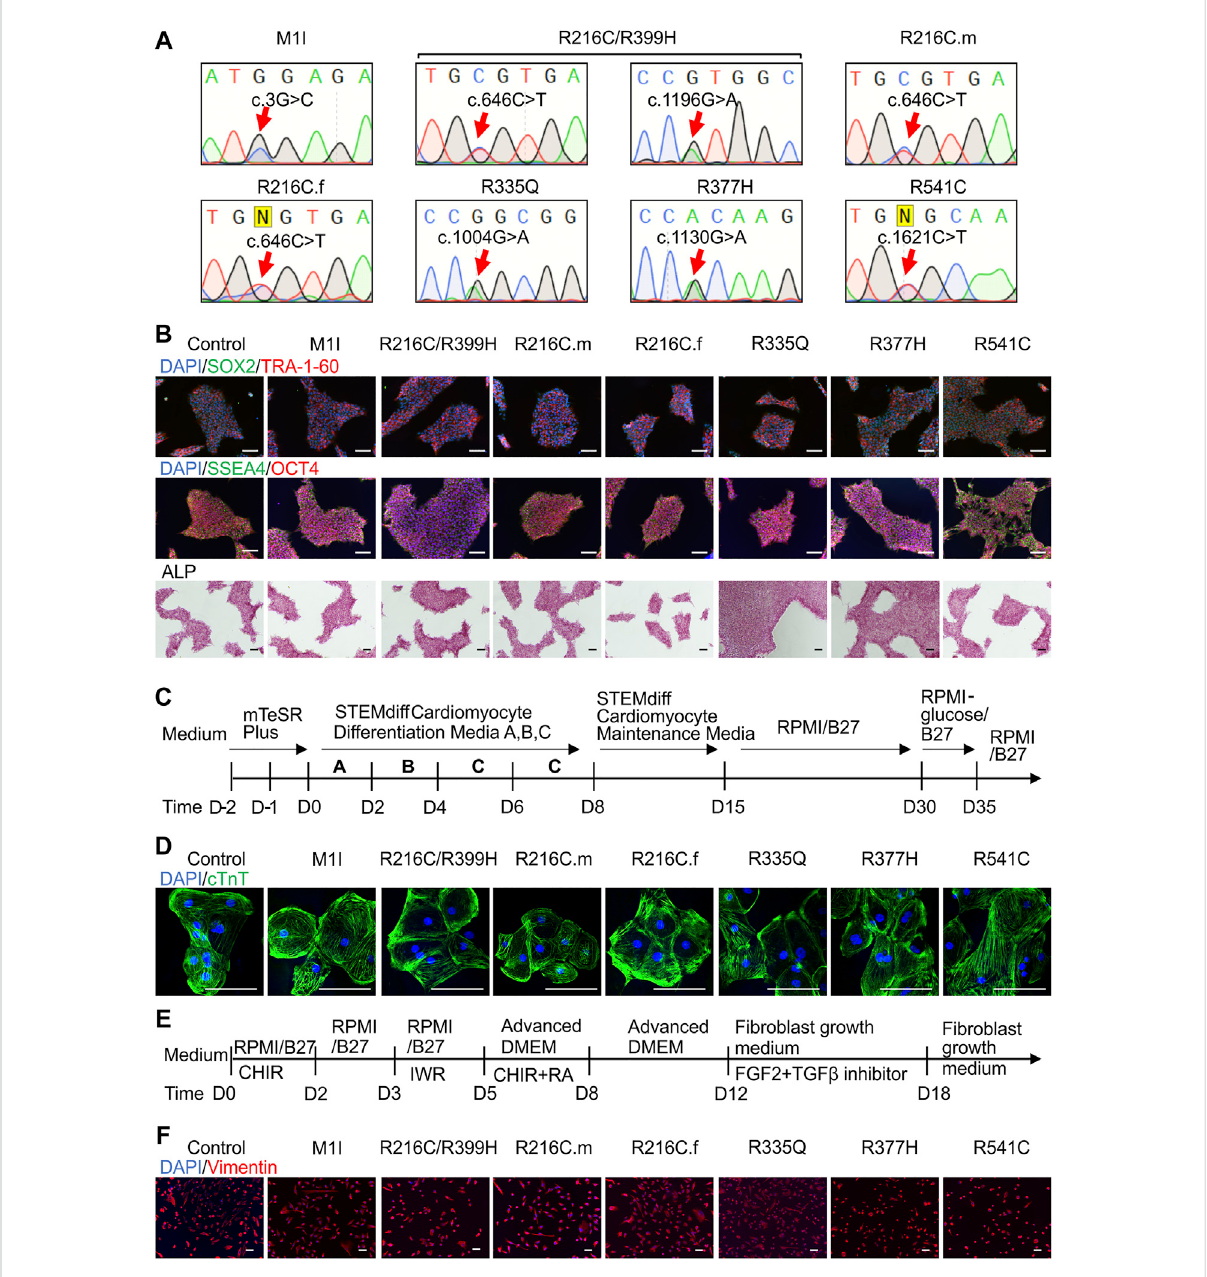
Differentiation and characterization of induced pluripotent stem cell (iPSC)-derived cardiomyocytes (iCMs) and cardiac fi broblasts (iCFs). (A) Sanger sequencing validates the presence of the individual mutation. (B) Representative staining of iPSCs expressing pluripotency markers SOX2 (green) and TRA-1-60 (red), SSEA4 (green), OCT4 (red), and alkaline phosphatase. Nuclei were stained with DAPI (blue). (C) Schematic of cardiac differentiation using STEMdiff ™ Cardiomyocyte Differentiation kit. (D) Immunostaining of cardiac troponin T positive cardiomyocytes.